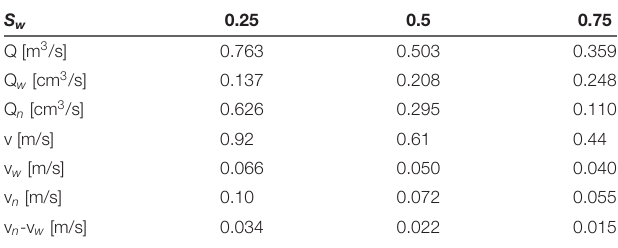
TABLE 5 | Volumetric flow rates Q and fluid velocities v for case (B) and three different choices for the